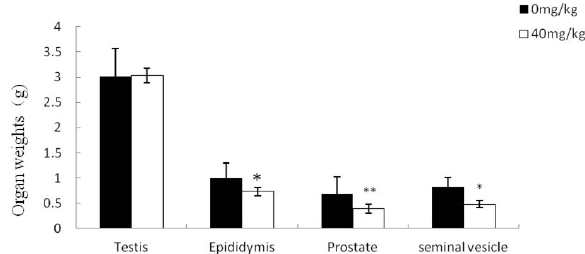
Figure 4. Effect of dutasteride treatment on reproductive organ weights. Data are represented as mean ˘ SEM. * p < 0.05 versus the control group; ** p < 0.01 versus the control